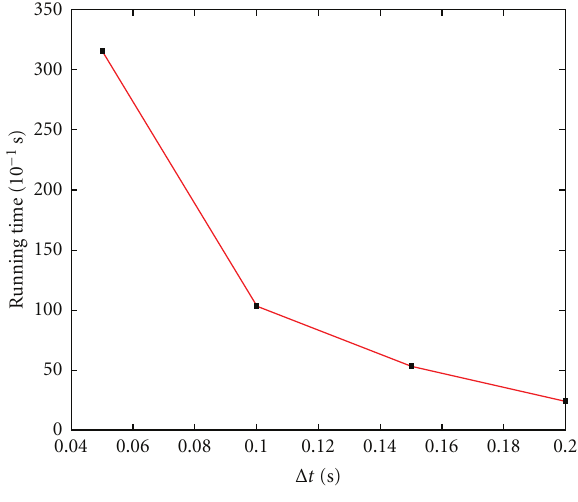
Figure 6: Running time versus Δ t